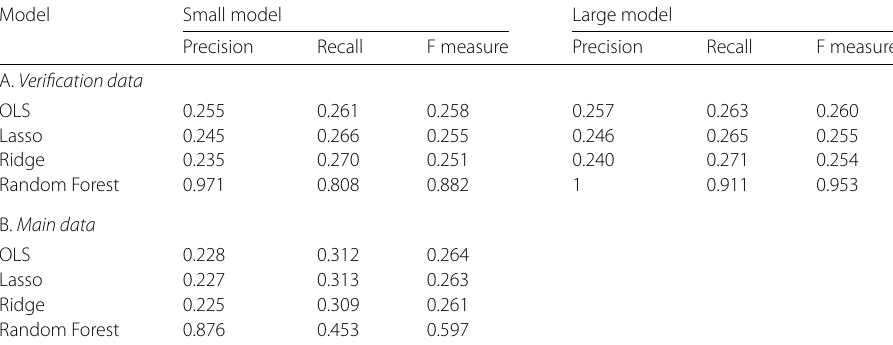
Table 8 Predictive accuracy across samples and models